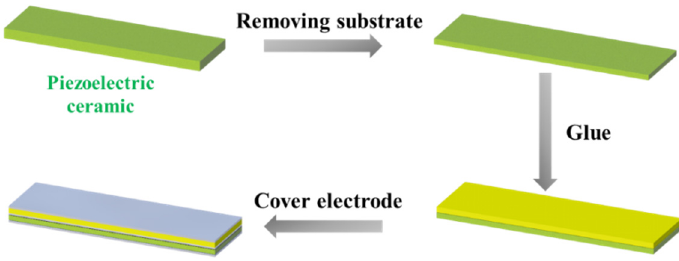
Figure 8. Flow chart of ceramic double-laminated element preparation.